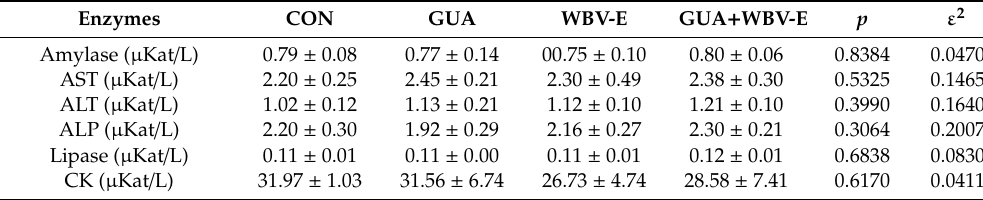
Table 3. Enzymes concentrations in animals submitted to some interventions.